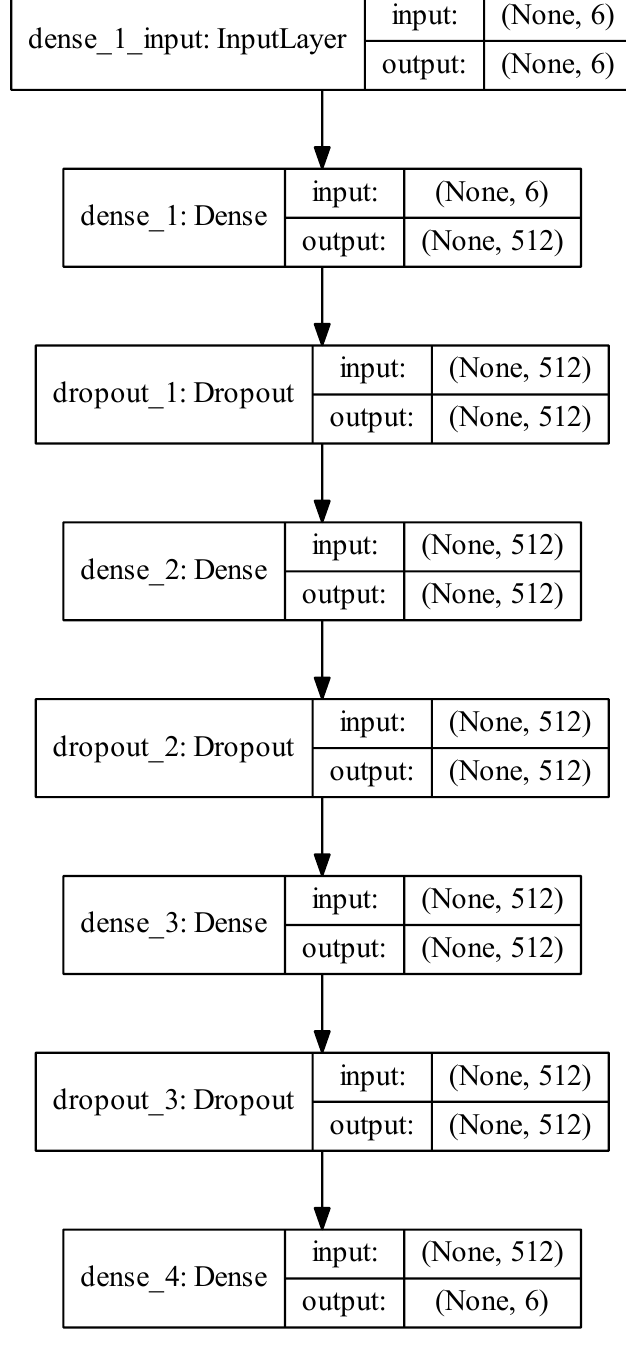
Figure 7. Visualization of the DNN for training the 2D two-strut tensegrity